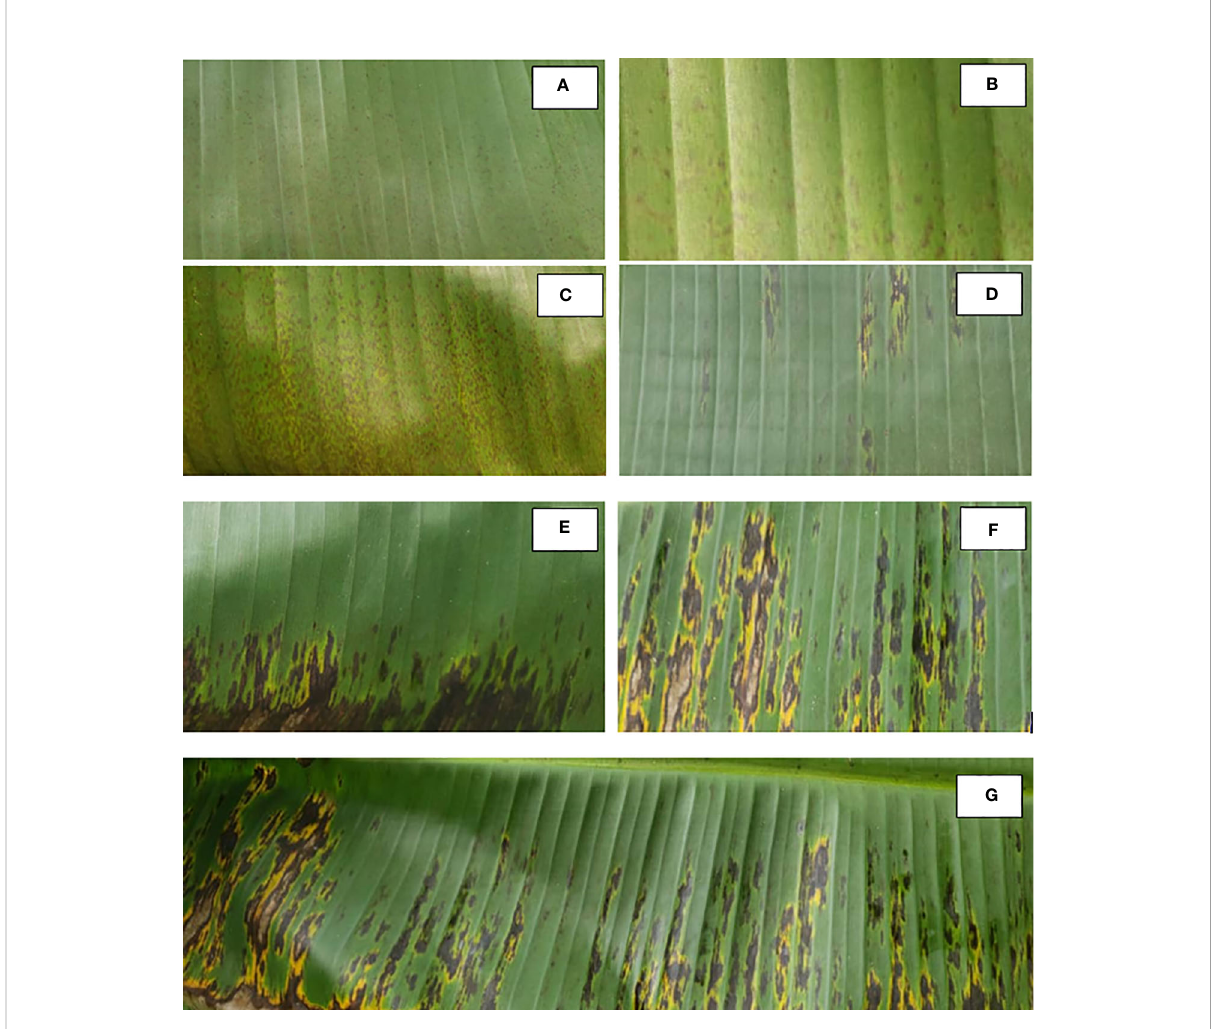
FIGURE 1 Evolution of black leaf streak disease symptoms observed in the fi eld in the central region of Cameroon (personal observation). (A) Stage 1 is the “ initial speck stage ” . (B) Stage 2 is the “ fi rst streak stage ” . (C) Stage 3 is the “ second streak stage ” . (D) Stage 4 is the “ fi rst spot stage ” . (E) Stage 5 is the “ second spot stage ” . (F) Stages 5 and 6 are the “ third or mature spot stages ” . (G) Overview of a sheet where all stages of development of BDS can be